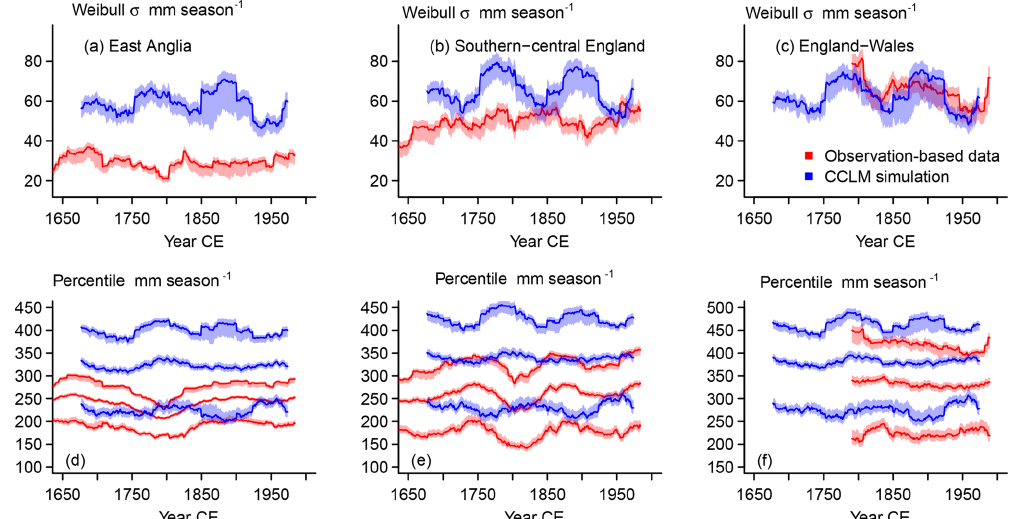
Figure B1. Visualization of uncertainty in the distributional properties. We use a bootstrap procedure on running estimates. We resample 40- year samples 1000 times from moving 51-year windows. Units are precipitation amounts. Shading represents 95% intervals, lines are medi- ans. (a, b, c) Weibull standard deviation. (d, e, f) Percentiles 93.3, 50, and 6.7. Red: reconstruction and observations. Blue: CCLM. (a, d) East Anglia, (b, e) southern–central England, and (c, f) England–Wales